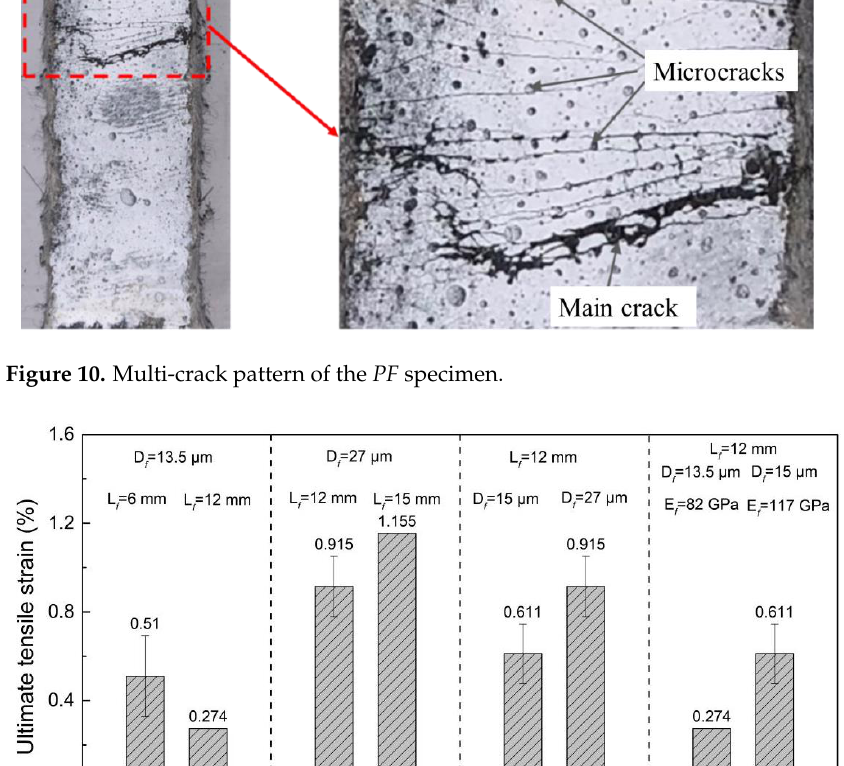
Figure 10 . Multi-crack pattern of the PF specimen.